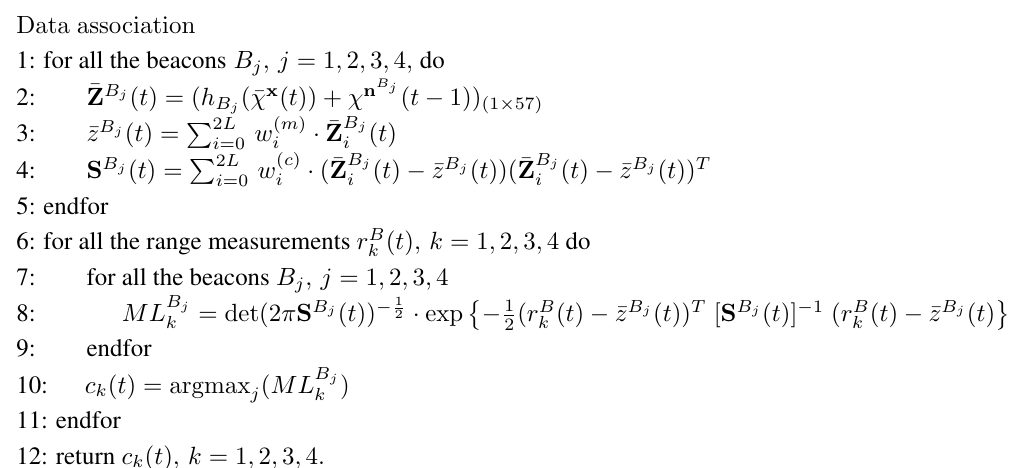
Table 2. Association of a beacon to a range